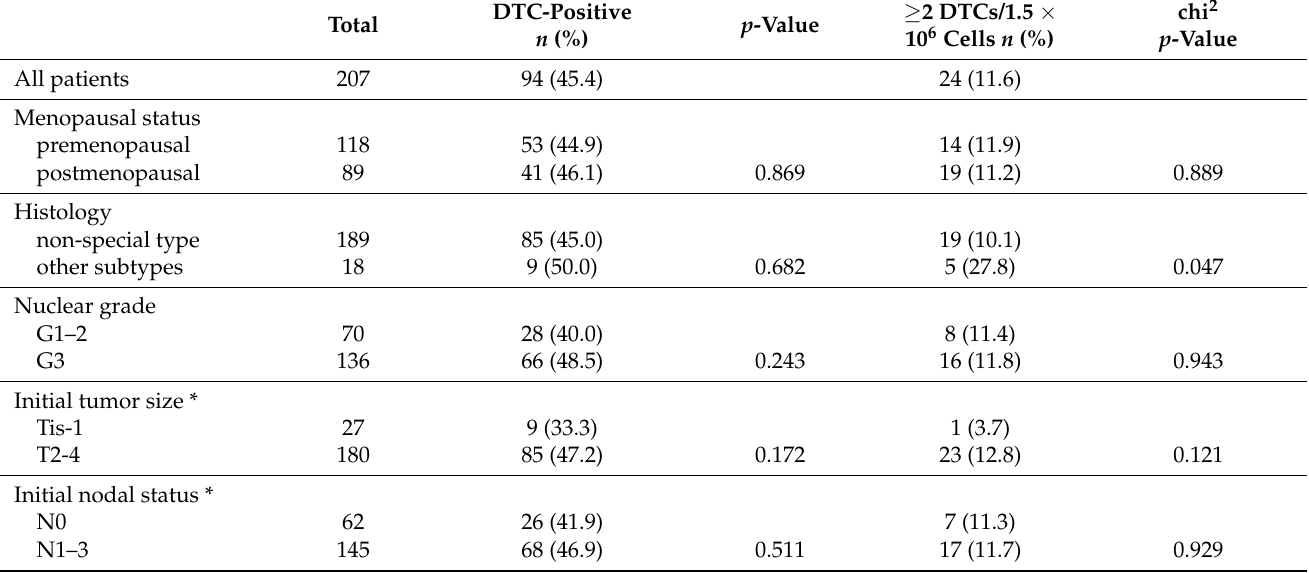
Table 3. Patient characteristics according to the detection of disseminated tumor cells (DTCs) in patients who received neoadjuvant